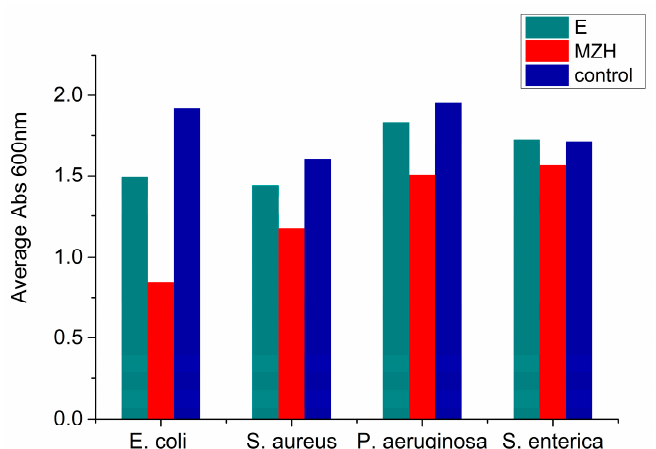
Figure 6. Demonstration of the sensitivity of some strains of bacteria to the action of cement mortars on the TSA medium: Escherichia coli ATCC 25922 ( E. coli ); Salmonella enterica ATCC 14028 ( S. enterica ); Pseudomonas aeruginosa ATCC 15442 ( P. aeruginosa ); Staphylococcus aureus ATCC 25923 ( S. aureus